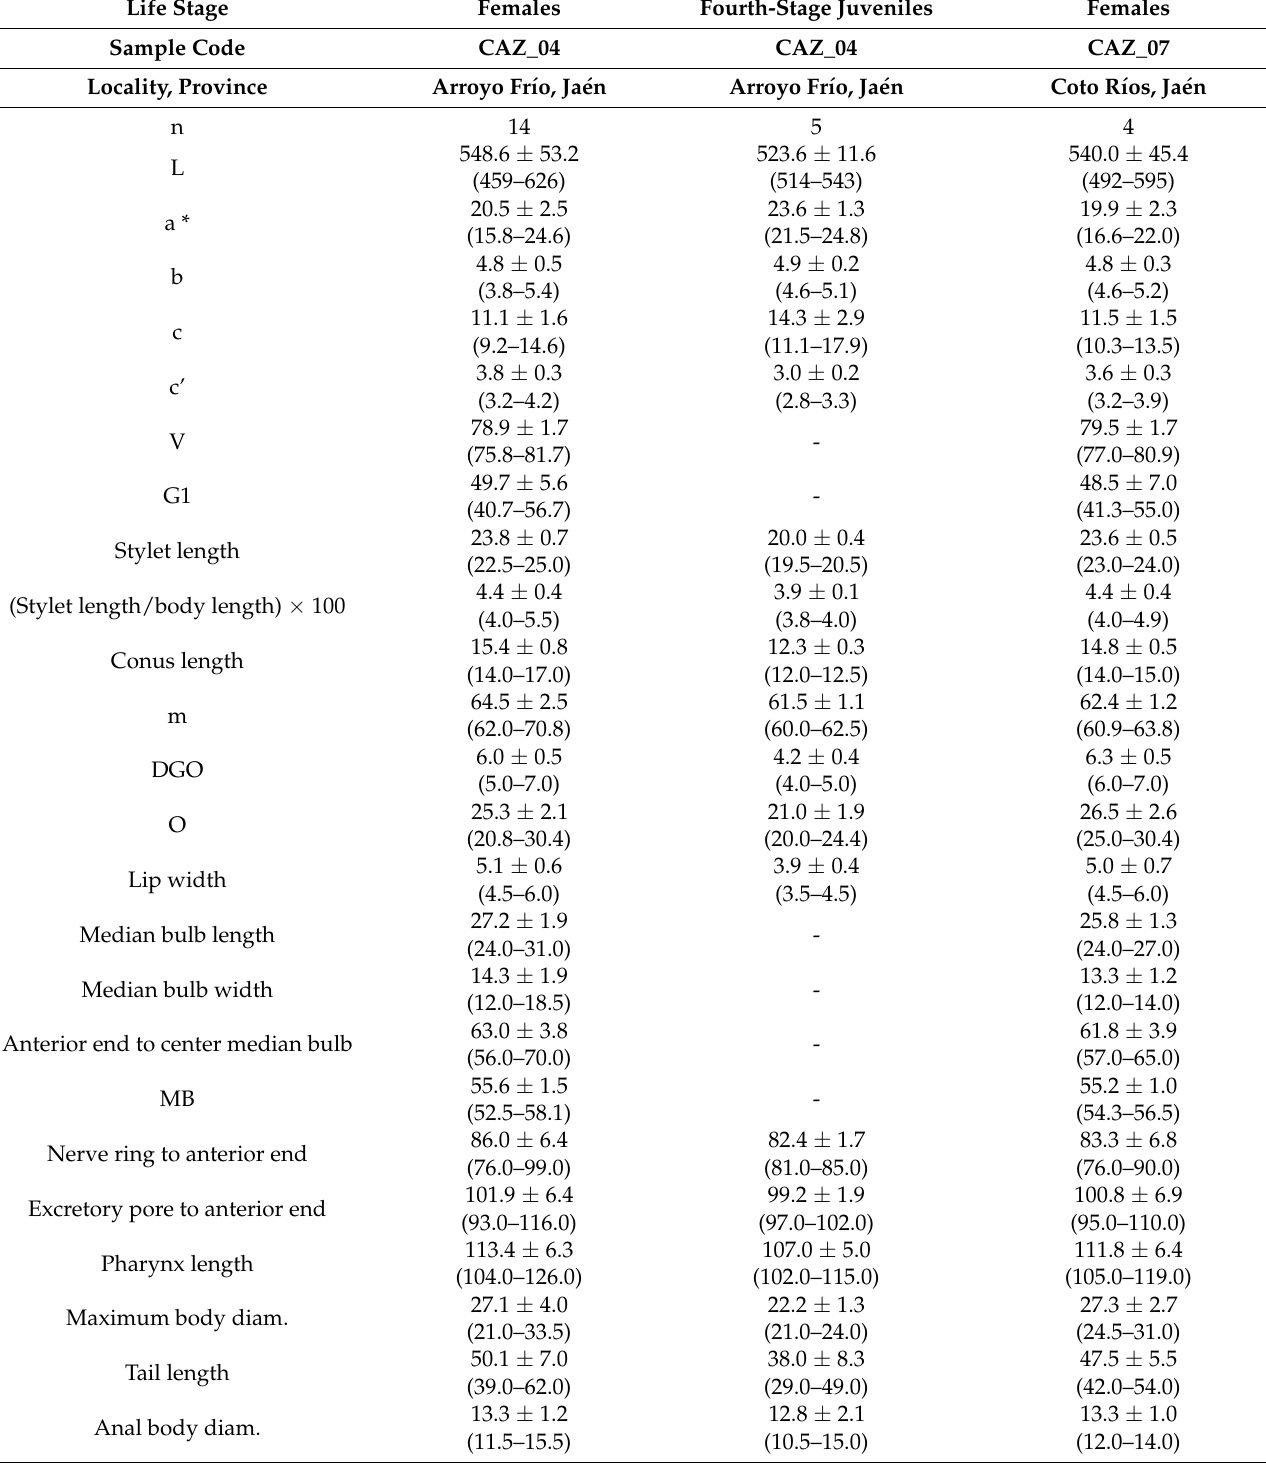
Table 10. Morphometrics of Paratylenchus sheri (Raski, 1973) Siddiqi, 1986 from Arroyo Fr í o and Coto R í os, Ja é n, Spain. All measurements are in µ m and in the form: mean ± s.d.